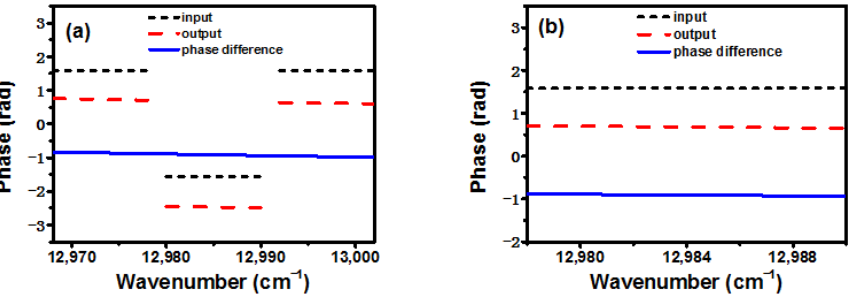
Figure 13. Schematic of the phases of the input, response, and the phase difference of ( a ) pump and ( b ) probe pulse.